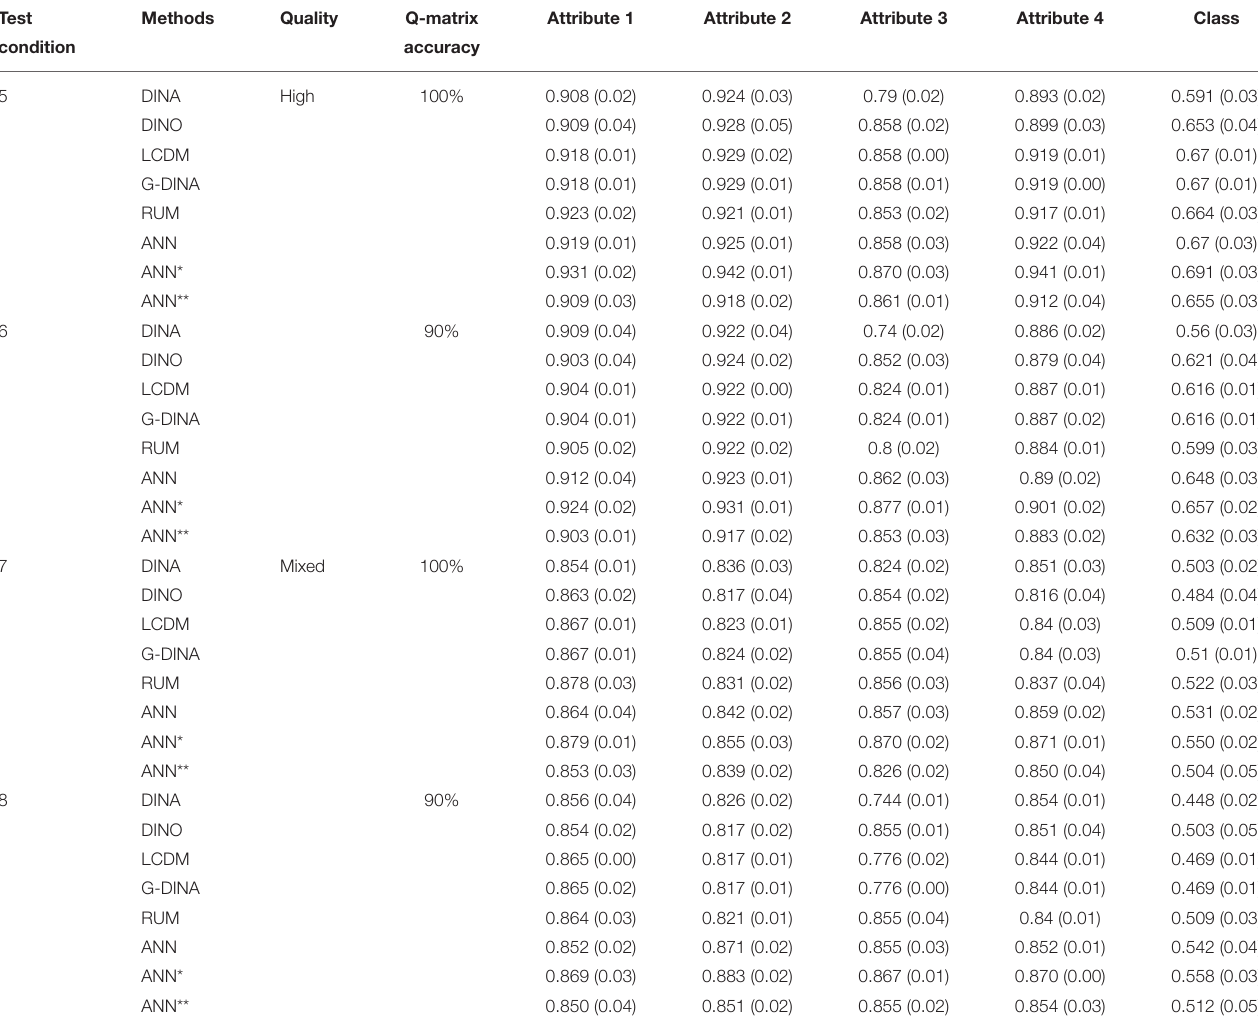
TABLE 3 | Comparison of classification rates for four attributes using 20